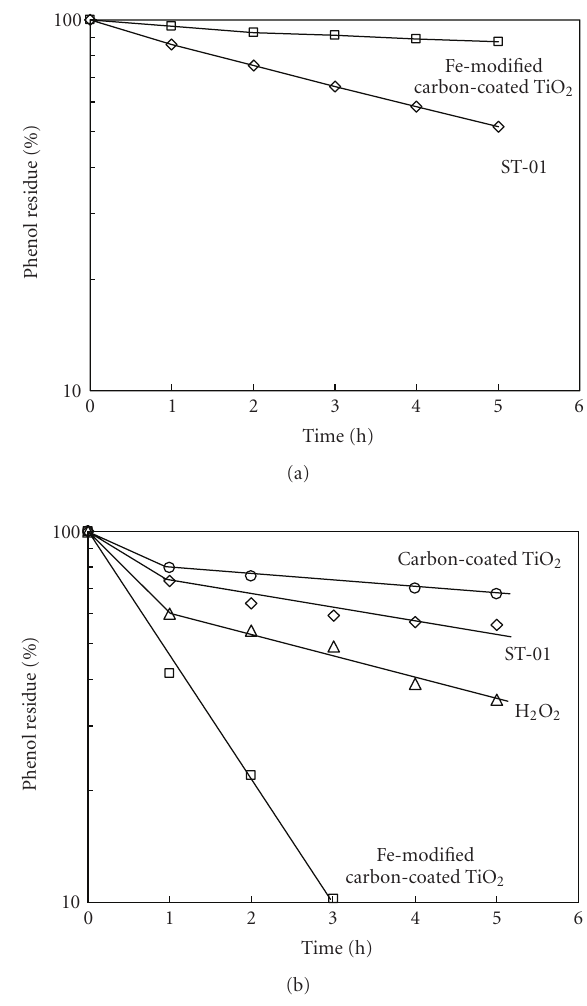
Figure 14: Phenol decomposition on commercial TiO 2 -ST-01 and modified TiO 2 by carbon and iron at 400 ◦ C, (a) under UV irradia- tion and (b) under UV with addition of H 2 O 2